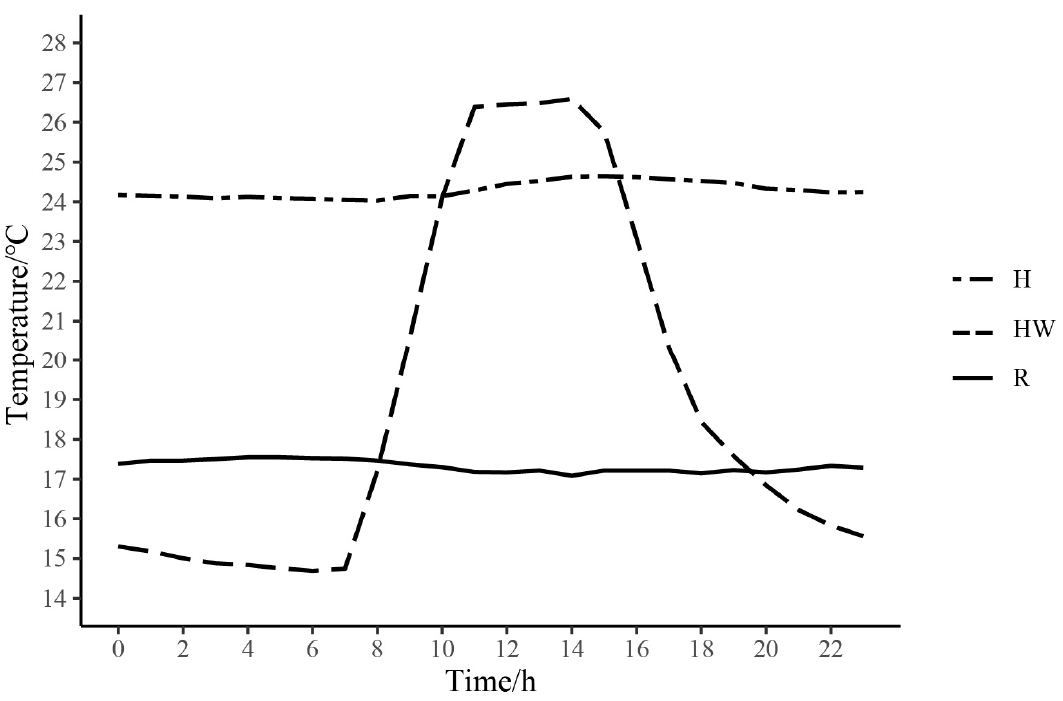
Figure 1. Changes in mean temperature of 24 h in the room temperature (R), high temperature (H), and heat wave (HW) groups for two weeks. Real-time temperatures were recorded by three iButtons (DS1921, MAXIM Integrated Products Ltd., USA) which were fixed in the middle of each box.